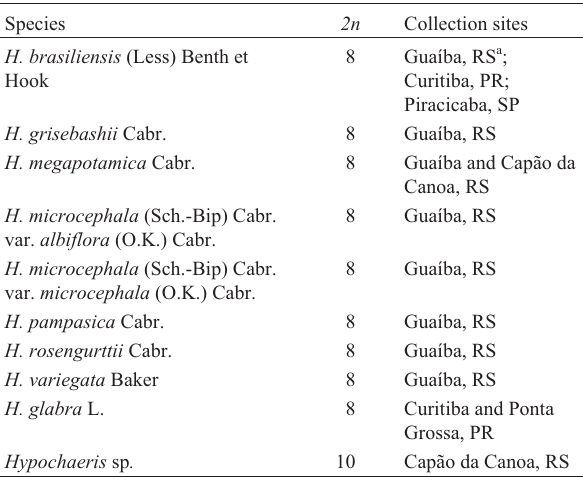
Table 1 - Chromosome numbers and collection sites of Hypochaeris species